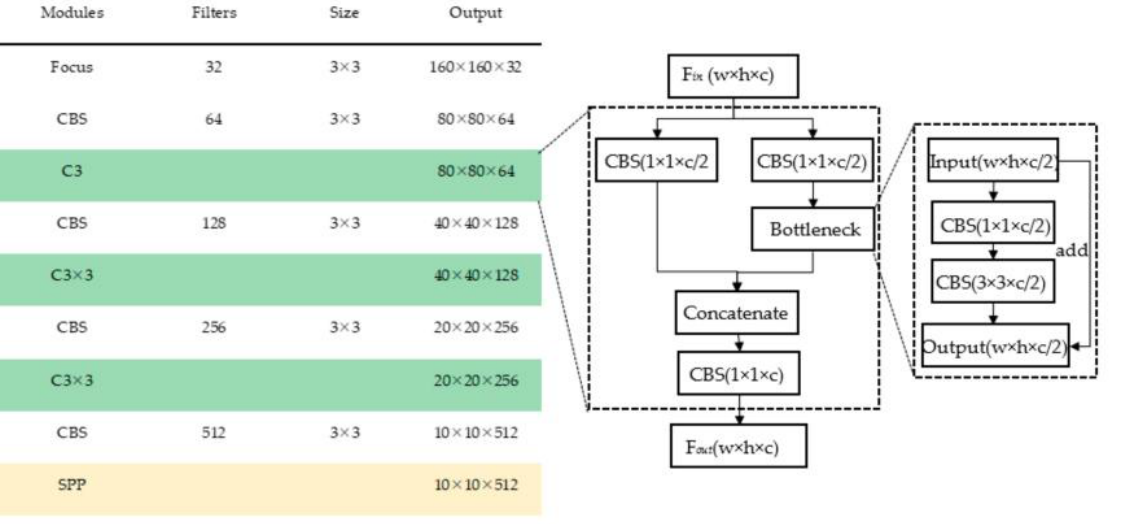
Figure 8. The detailed structure of Backbone, including the number of filters, the filters size and the feature map shape of each